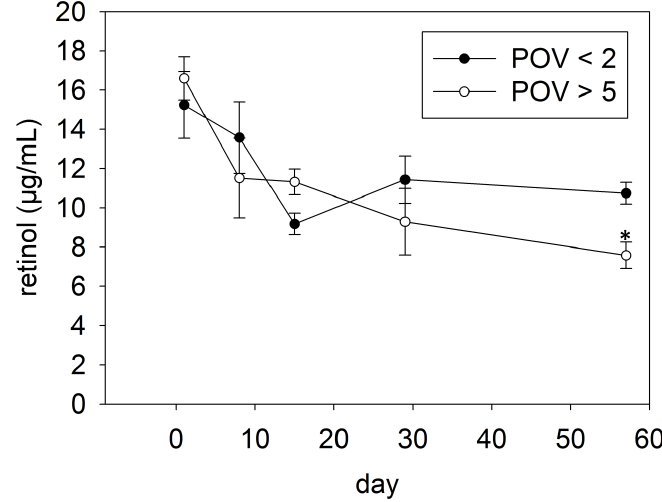
Figure 5. Vitamin A stability in mildly and highly oxidized palm oil stored under household-representative conditions for up to 57 days. Data are expressed as mean ± SEM ( n = 4). Asterisks (*) indicate a statistically significant difference vs. day 1 ( p < 0.05).